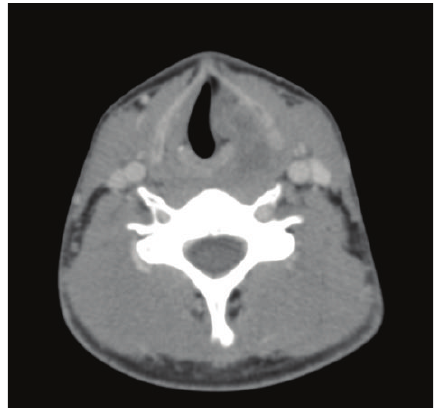
Figure 2: CT scan of neck, axial view, showing laryngotracheal deviation.